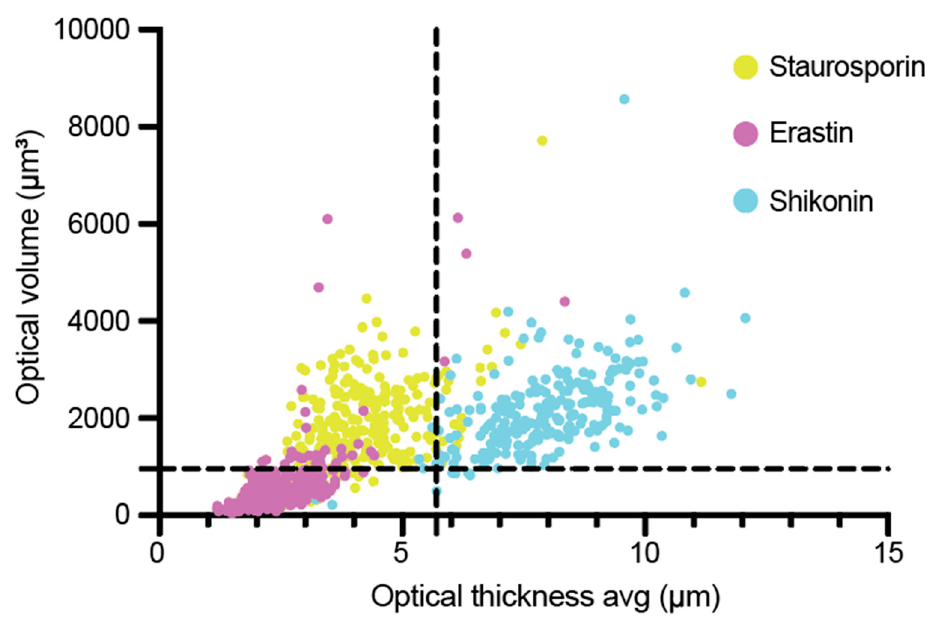
Figure 6. Average optical thickness plotted against optical volume for cells in indicated conditions. Dotted lines indicate threshold used for 2-node model presented in Figure 7.